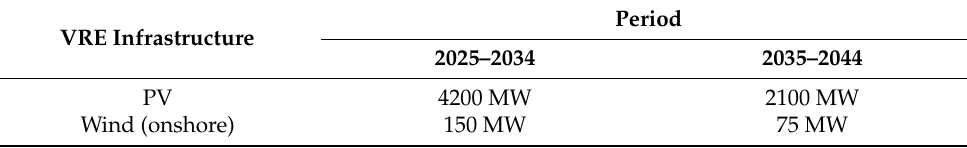
Table 3. Existing VRE capacity of Company